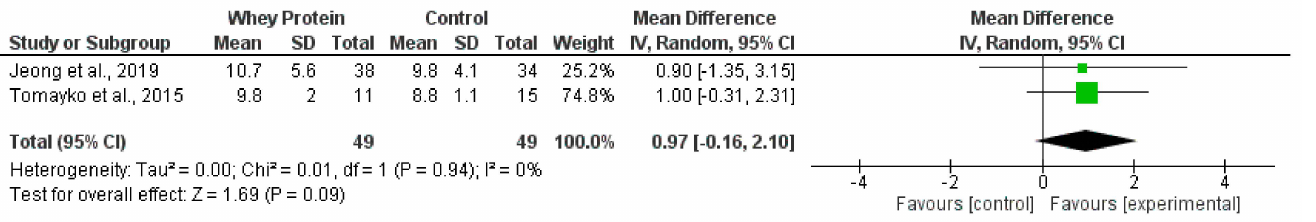
Figure 5. Effect of whey protein supplementation on sit-to-stand test 30 (repetitions) in individuals receiving haemodialysis. Data are expressed as mean difference and 95% CI. Data for whey protein and control groups from both trials [22,66].